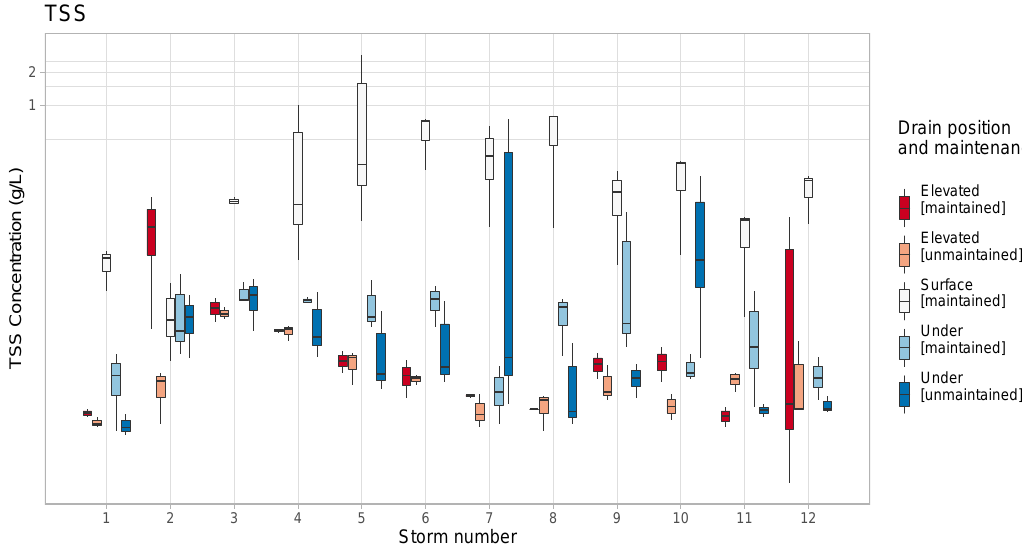
Figure 2. Boxplots show the distributions of geometric means of TSS concentrations for 12 storms, grouped by cell maintenance regime and drain position. Effluent concentrations from the surface of Impervious Asphalt (IA) cells served as the study